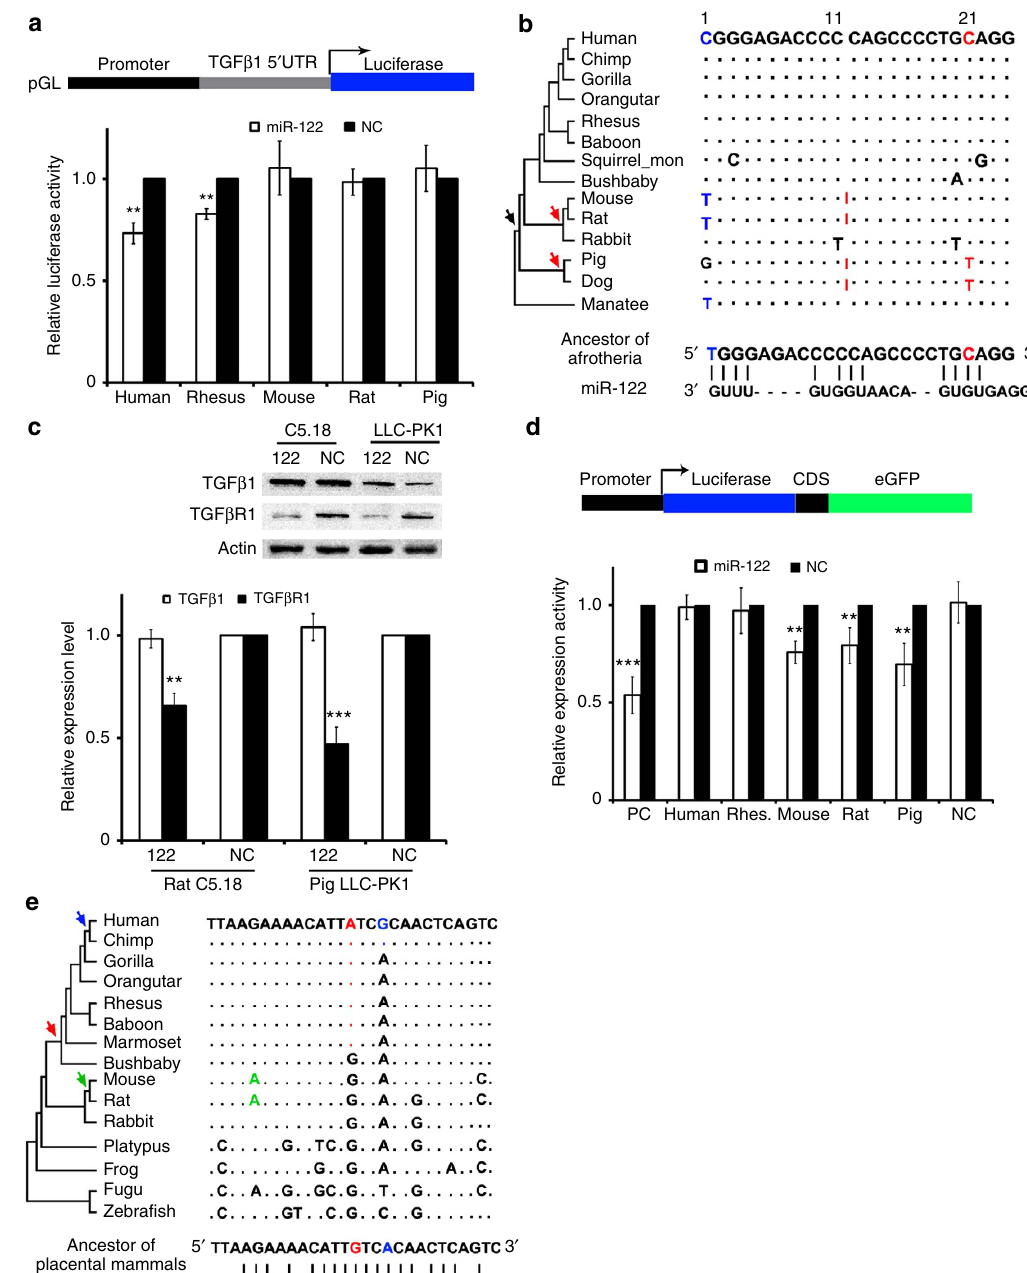
Figure 3 | Evolutionary analysis of miR-122 targeting TGF b 1/TGF b R1 in vertebrates. ( a ) Luciferase activity was measured after transfection of the indicated reporter constructs. TGF b 1 5 0 UTR was cloned into the promoter region of a pGL plasmid. Rhesus, Rhesus monkey. Six independent repeats are performed in each experiment. ( b ) The evolutionary trajectory of the miR-122 target site in the TGF b 1 5 0 UTR in animals. The gain of the miR-122 target site occurs in the common ancestor of the manatee and humans as well as other primates (black arrow), while the loss of this site in the pig, dog, rat or mouse due to the insertion of a few of bases between the 11th and 12th bases (red arrow). The dot means the nucleotide is identical to the one in humans, and the red line means the insertion of one or a few of bases. For the predicted miR-122 target site in each species, the luciferase assay was performed. ‘ þ ’ denotes the silence effect, and ‘ (cid:2) ’ denotes no silence effect. Experimental data were shown in Supplementary Fig. 3d. ( c ) Expression levels of TGF b 1 or TGF b R1 in C5.18 (rat cells) or LLC-PK1 (pig cells) transfected with an miR-122 expression plasmid or NC. Quantitative analysis is shown below and three independent repeats are performed in each experiment. ( d ) Luciferase activity was measured after transfection with the indicated reporter constructs. The candidate